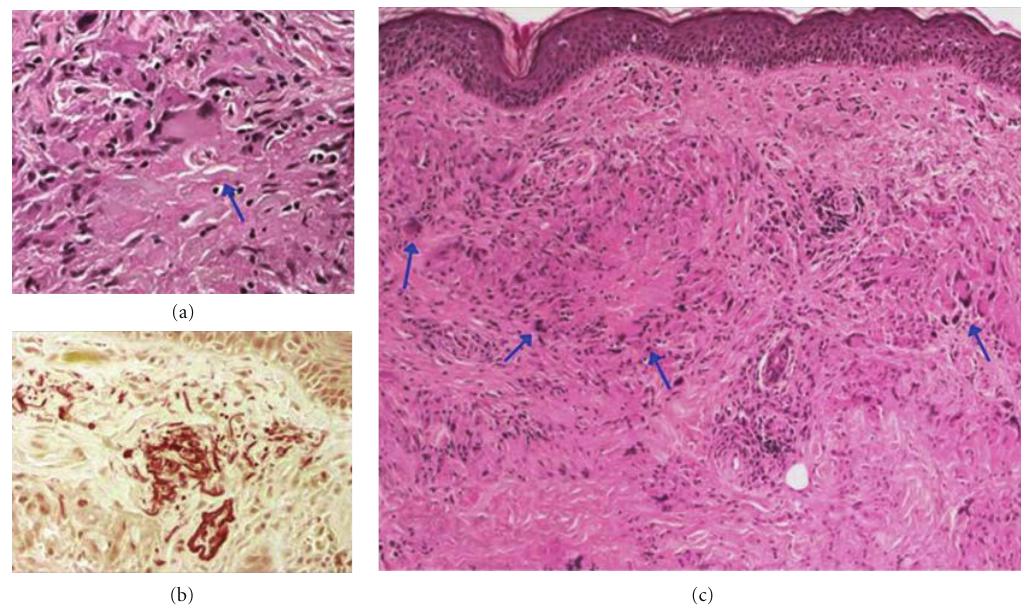
blood disorders, liver injury, and ophthalmic toxicity, the last one identified in the